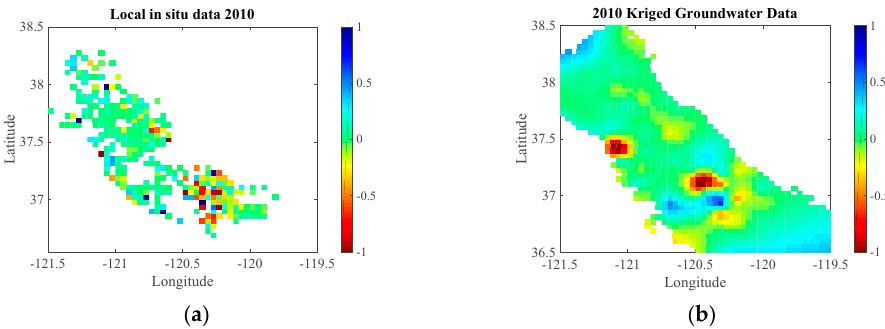
Figure 2. ( a ) Map of annual change in groundwater storage (m) from available in situ well levels for 2010; ( b ) Map of annual change in groundwater storage (m) from kriged in situ well levels for 2010.